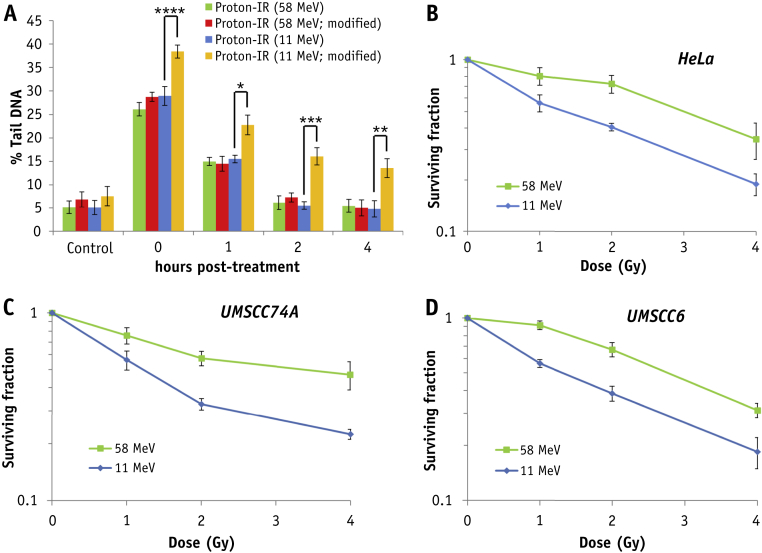
High linear energy transfer (LET) protons directly induce persistent complex DNA damage (CDD) formation, which contributes to increased radiosensitivity. (A) HeLa cells were irradiated with 4 Gy protons at low or high LET and CDD measured at various time points after ionizing radiation (IR) by the enzyme-modified neutral comet assay in the absence or presence (indicated as modified) of APE1, NTH1, and OGG1. Shown is the percent tail DNA ± standard deviation. *P < .02, **P < .01, ***P < .005, ****P < .001, as analyzed by a one-sample t test. Clonogenic survival of (B) HeLa, (C) UMSCC74A, and (D) UMSCC6 cells after protons at low or high LET. Shown is the surviving fraction ± standard error. A comparison of the surviving fraction at 2 Gy (SF2) is statistically significantly different by one-way analysis of variance (P < .02 for HeLa and UMSCC74A; P < .01 for UMSCC6).